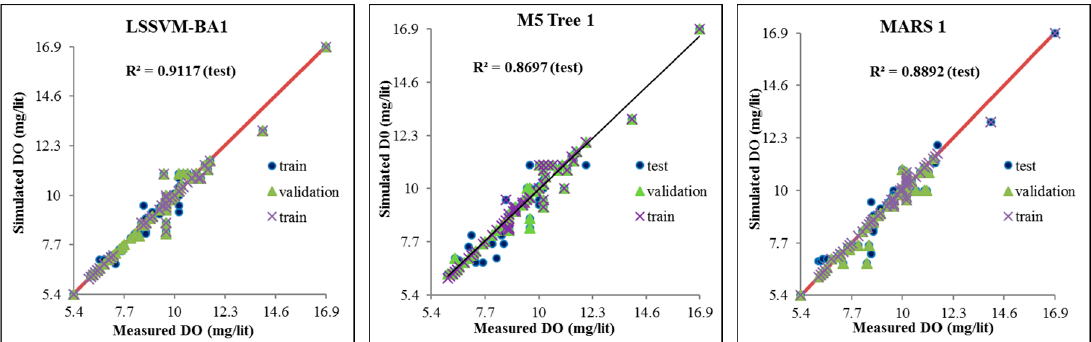
Figure 6. Scatter plot of observed and simulated DO concentration by three predictive models during model training, validation, and testing at USGS 01463500.